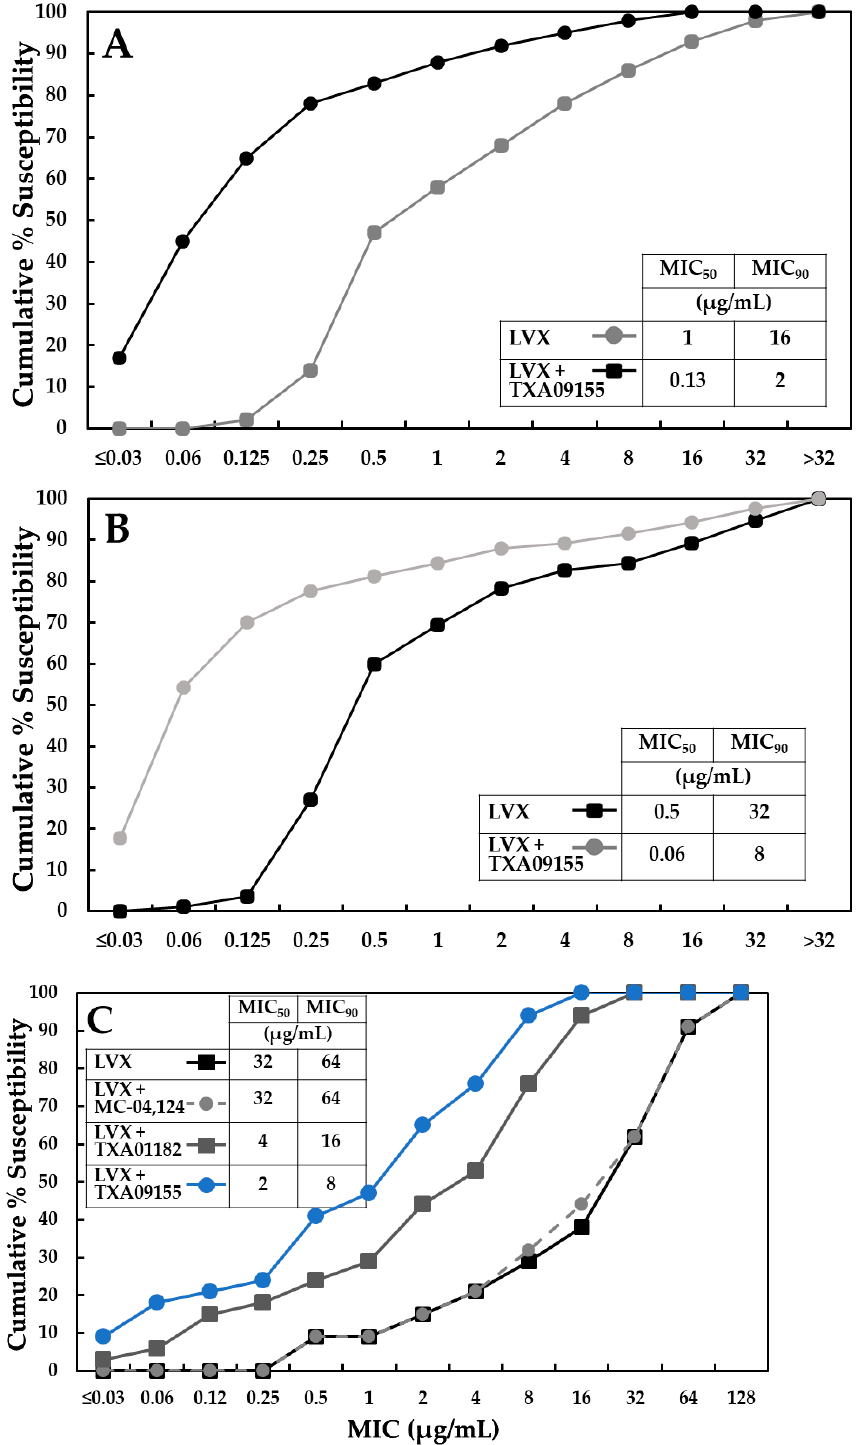
Figure 5. The activity of the TXA09155/levofloxacin combination against 209 clinical isolates from across the US ( A ); 300 clinical isolates from 66 countries ( B ); and 44 CDC/FDA MDR clinical isolates ( C ) of P. aeruginosa were determined with a fixed concentration of TXA09155 (6.25 µg/mL). MC-04,124 and TXA01182 were used as comparator EPIs at a fixed concentration of 6.25 µg/mL. Datapoints represent the percentage of strains in each panel susceptible to the indicated levofloxacin concentration.